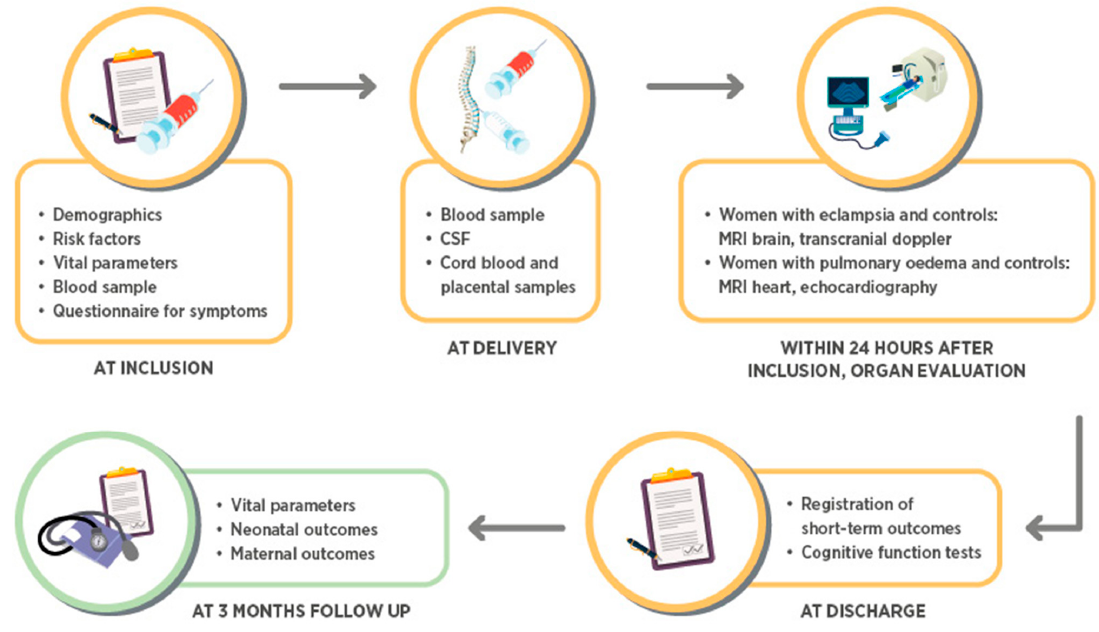
Figure 1. Flow chart of the study.